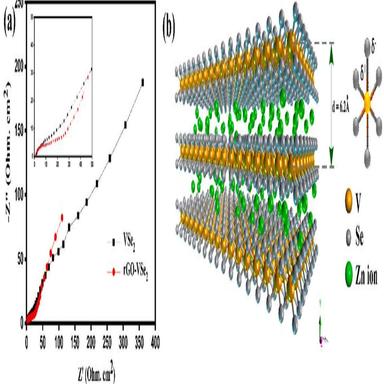
(a) Nyquist plots of pure VSe2 and rGO-VSe2 nanohybrid; and (b) schematic illustration of Zn storage in rGO-VSe2 nanohybrid.